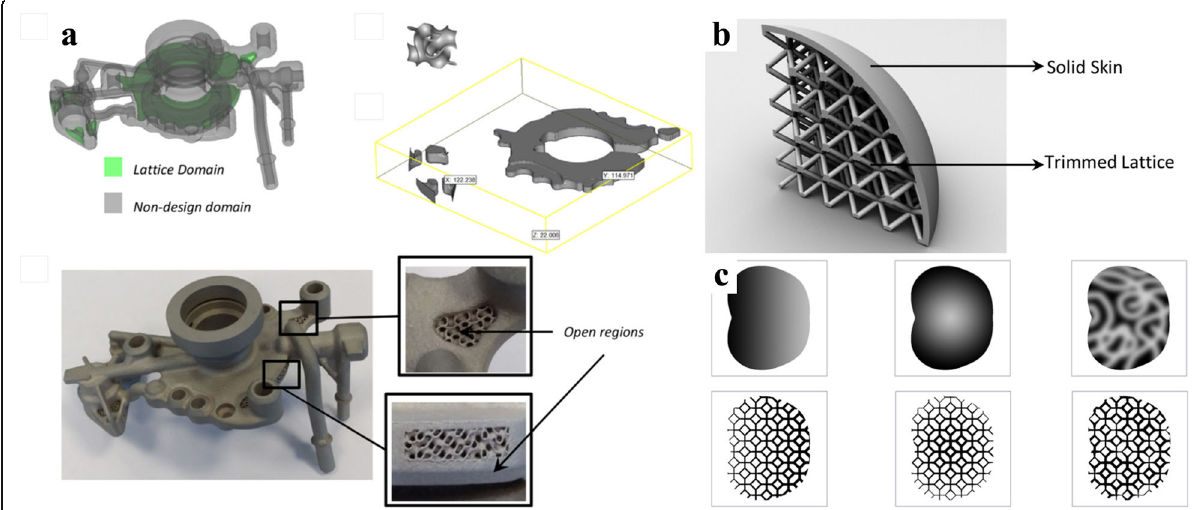
Fig. 23 The functionally graded lattice structure design: a Product designed with Gyroid lattice. b Lattice model with solid skin. c Functionally graded structures [52]